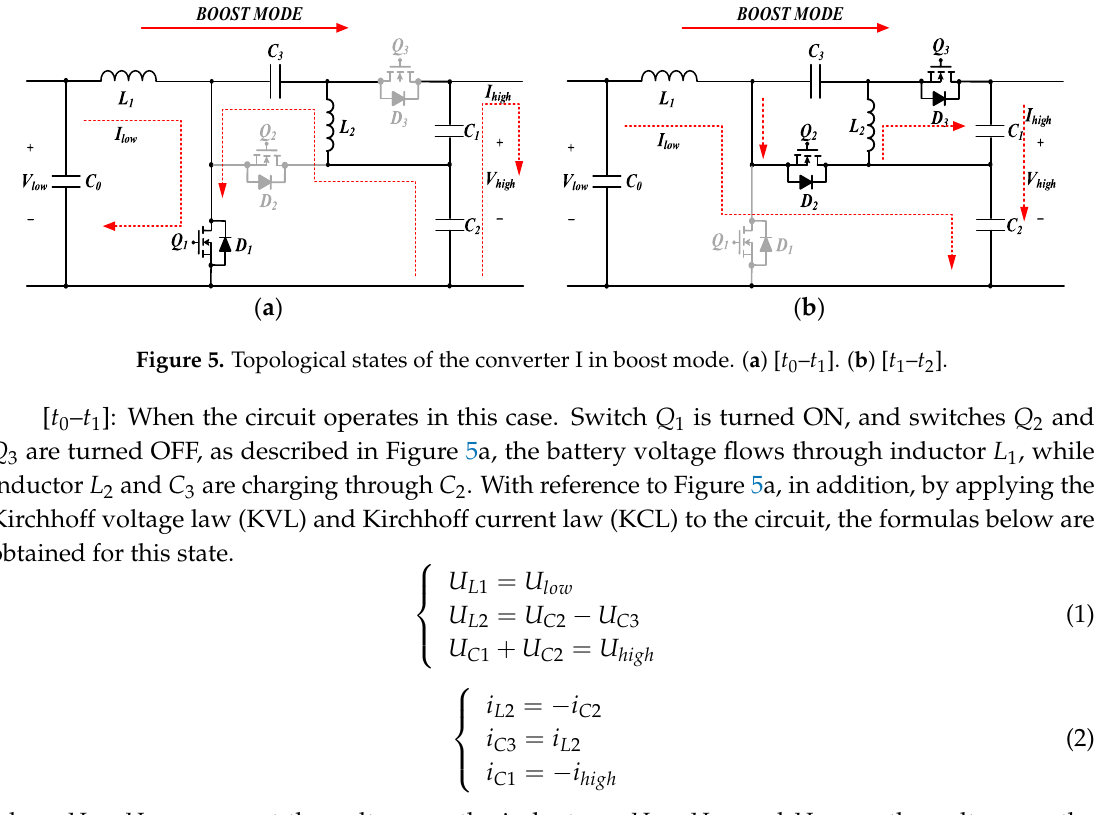
Figure 4. Main waveforms of ( a ) boost and ( b ) buck modes (converter I &II).